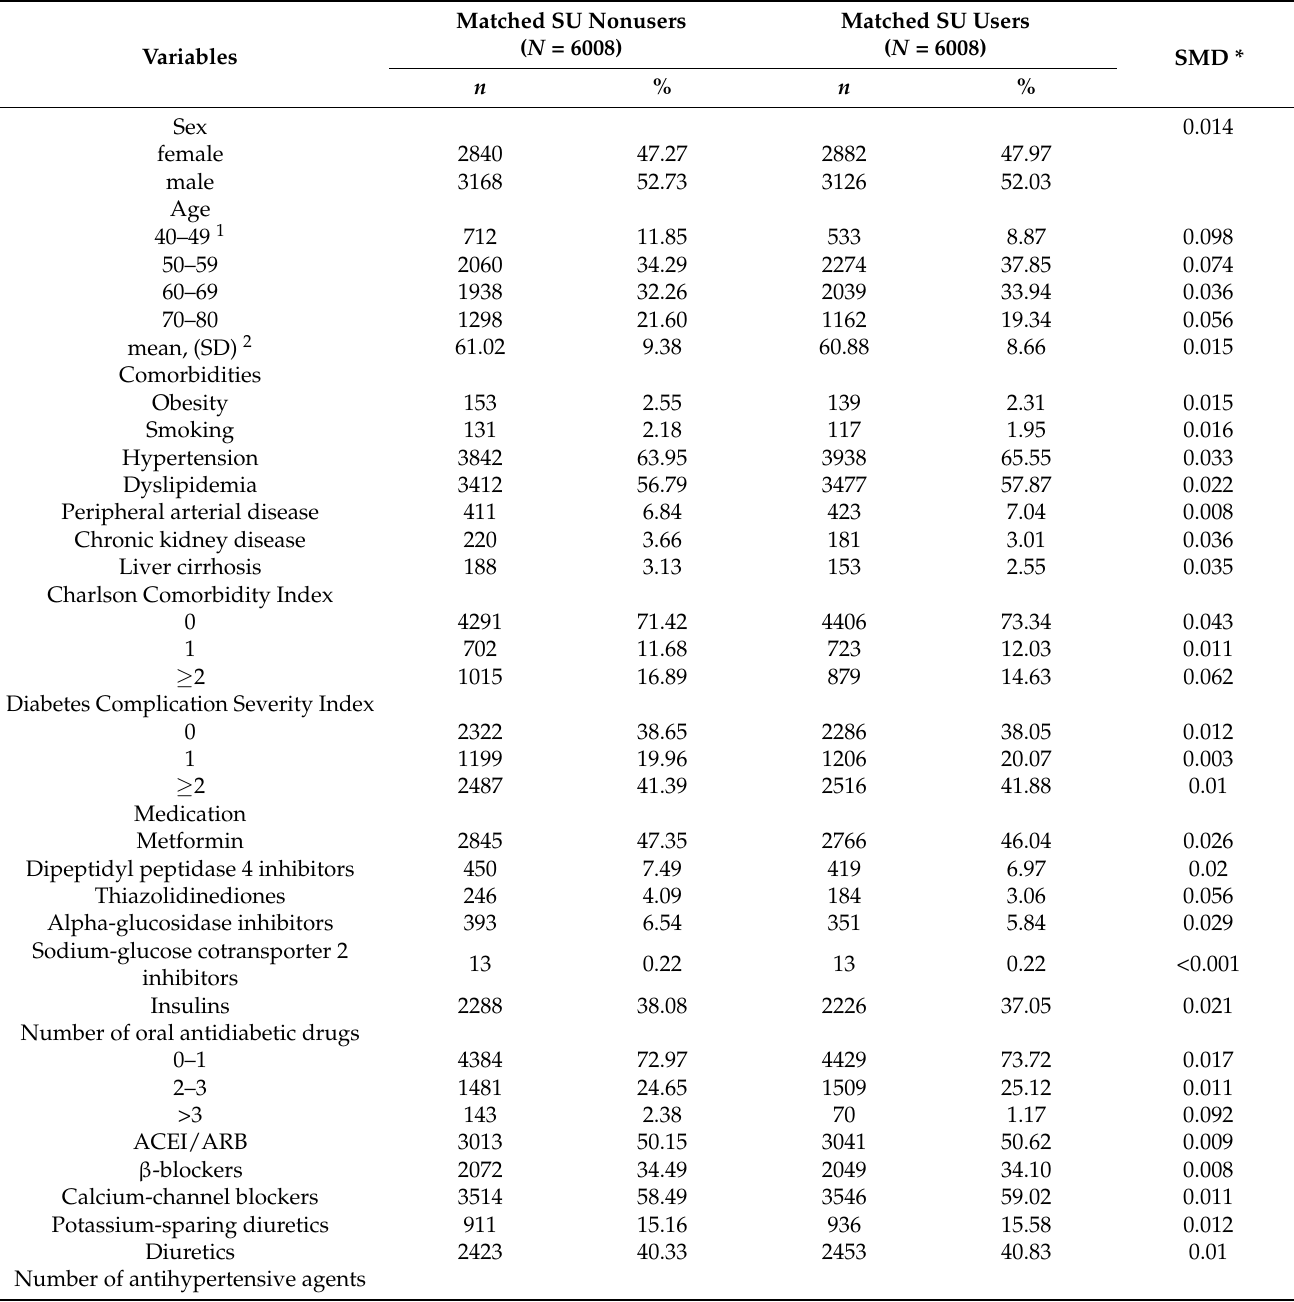
Table 1. Baseline characteristics of patients with and without